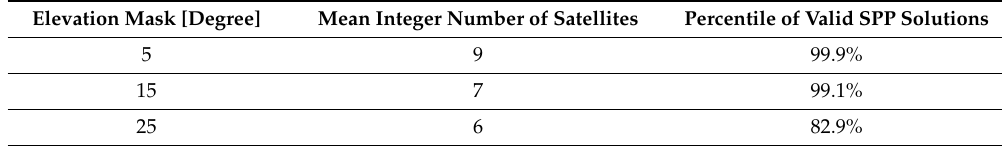
Table 2. Mean number of satellites used in SPP and percentiles of valid SPP solutions applying different elevation masks. Note that the mean satellite numbers are given as rounded values. The real values of the mean satellite numbers amount to about 8.5, 7.4, and 5.7 for an elevation mask of 5, 15, and 25 degrees, respectively.